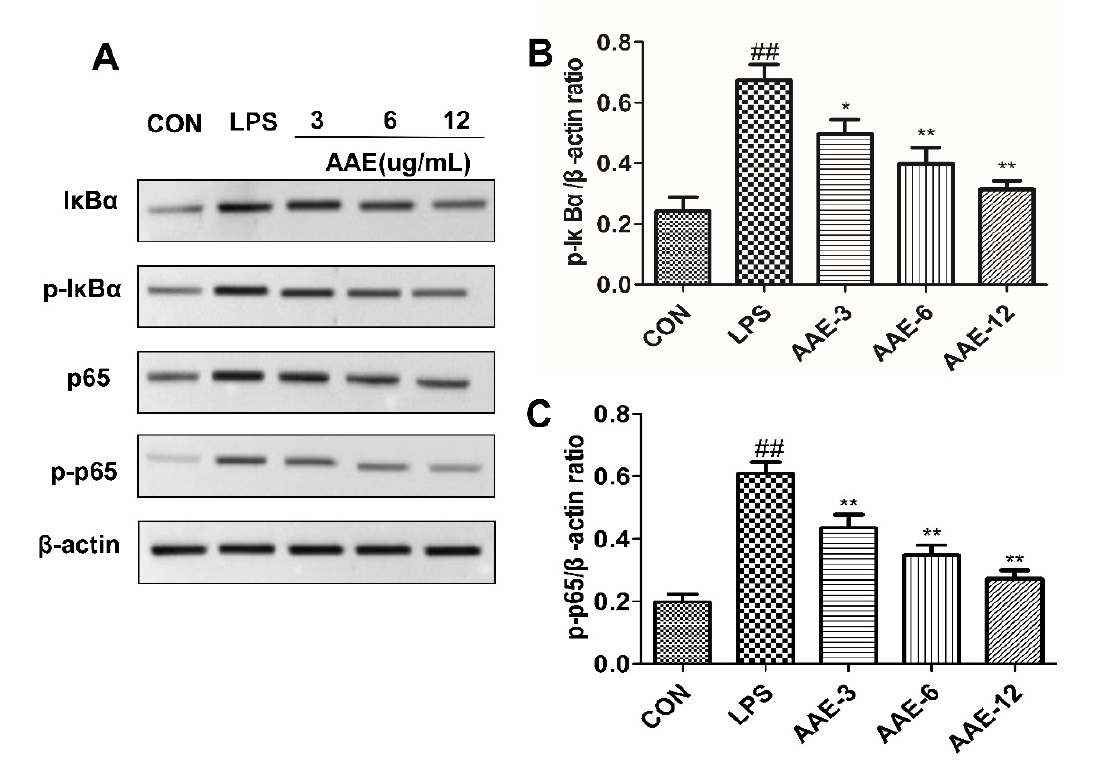
Figure 8. AAE pretreatment suppressed the LPS-induced activity of the NF- κ B pathway. The bMECs were treated in the absence or presence of AAE (3, 6, 12 μ g/mL) for 3 h, and then treated with 10 μ g/mL LPS for 12 h. ( A ) Western blotting analysis was performed to test I κ B α , p-I κ B α , p65 and p-p65 protein levels; β -actin was used as endogenous control. The complete Western blotting images are shown in Figure S3. ( B ) Relative protein expression levels of p-I κ B α to β -actin. ( C ) Relative protein expression levels of p-p65 to β -actin. CON: cells were cultured in medium (serum-free) for 15 h; LPS: cells were cultured in medium (serum-free) for 3 h and then incubated with 10 μ g/mL LPS for 12 h; AAE-3, AAE-6 and AAE-12: cells were treated with 3, 6 and 12 μ g/mL AAE for 3 h before 10 μ g/mL LPS incubation for 12 h. Comparisons among groups were made with ANOVA followed by Duncan’s test. The data are expressed as mean ± SEM ( n = 3). ## p < 0.01 vs. CON. * p < 0.05 and ** p < 0.01 vs. LPS.